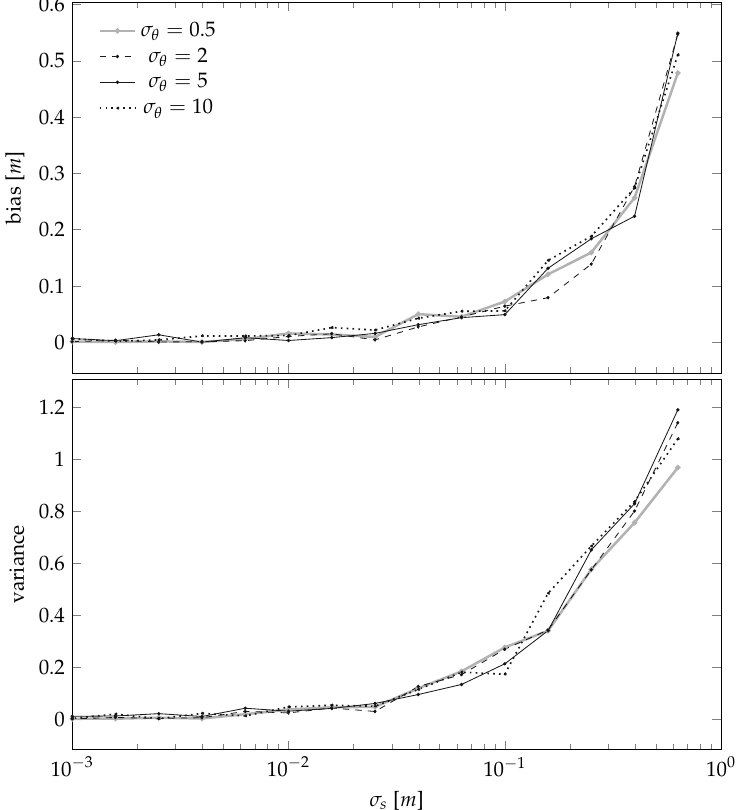
Figure 7. Bias and variance of the landmark position estimator of Section 3.1 as a function of the uncertainty in the sensor position evolution σ s for different sensor-to-landmark angle measurement standard deviations σ θ ’s (in degrees) for the case L = 1.